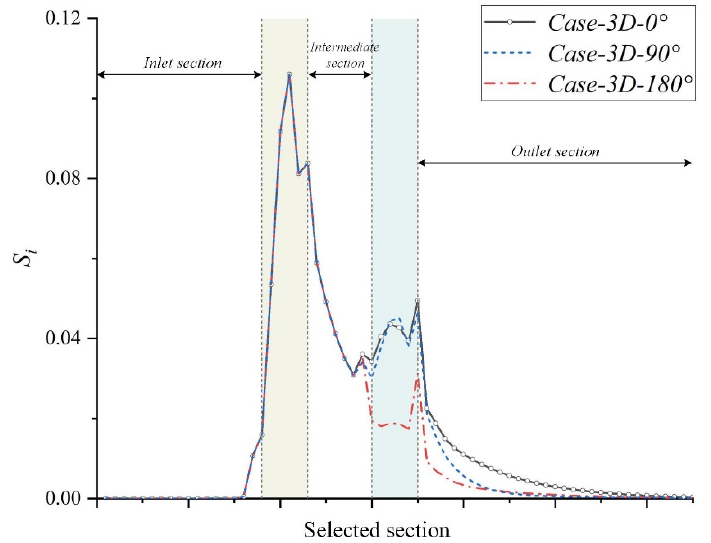
Figure 10. Swirl strengths S i along the pipes in Case-0 ◦ -3D , Case-90 ◦ -3D , and Case-180 ◦ -3D .